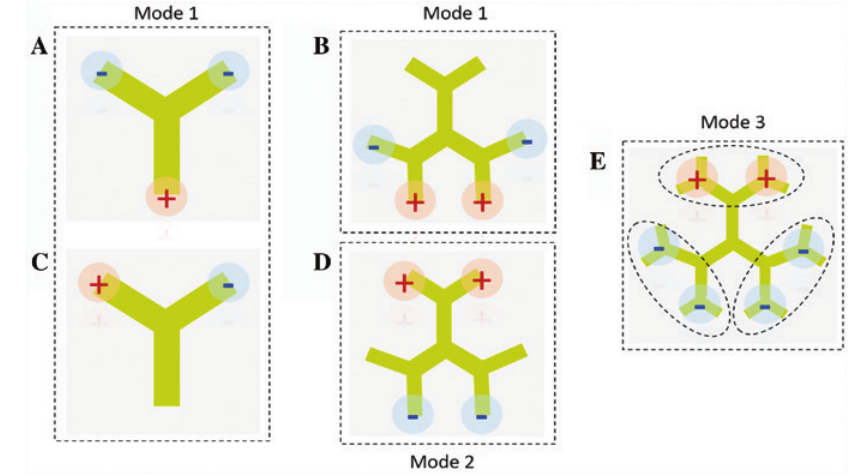
Figure 5: Schematic depicting the configuration of charges for different resonance modes of a Cayley tree fractal for the first, second, and third order.